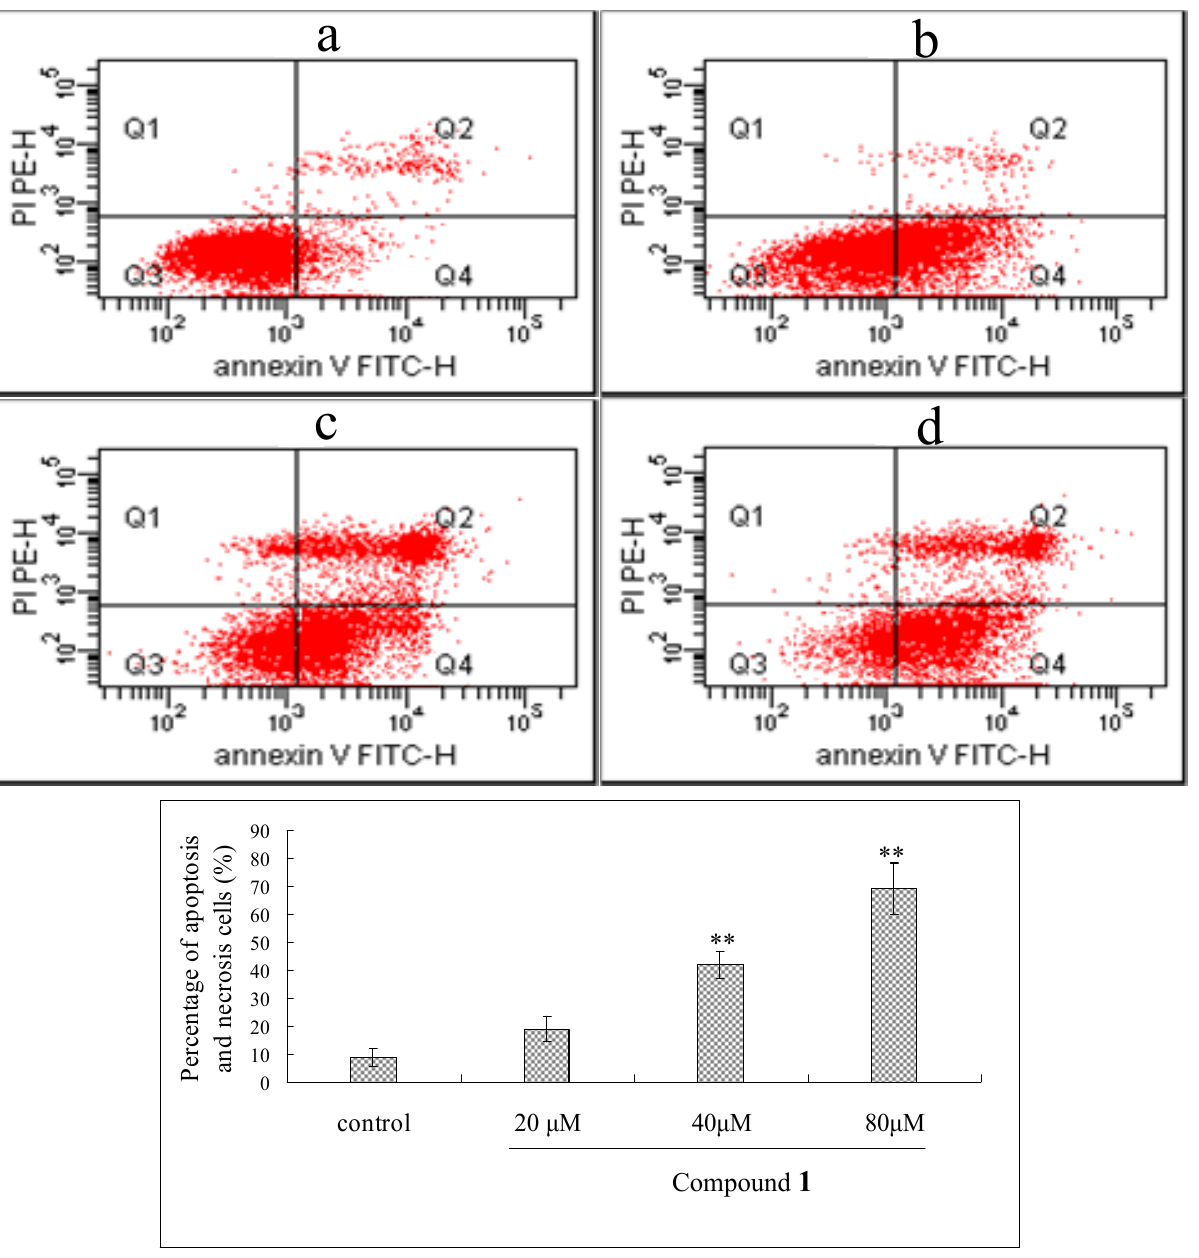
Figure 4. Flow cytometric analysis of Bel-7402 cells apoptosis following exposed to compound 1. Annexin V/PI double-staining assay of Bel-7402 cells. X axis shows FITC-labeled Annexin V positive cells and Y axis shows PI labeled population. The percentage of those four sections cells was indicated. ( a ) control, cells were not treated with compound 1 ; ( b-d ) cells were treated with compound 1 at concentrations of 20, 40 and 80 μ M, respectively. The data are represented as mean ± S.D for six independent experiments. * P < 0.05 and ** P < 0.01 vs.